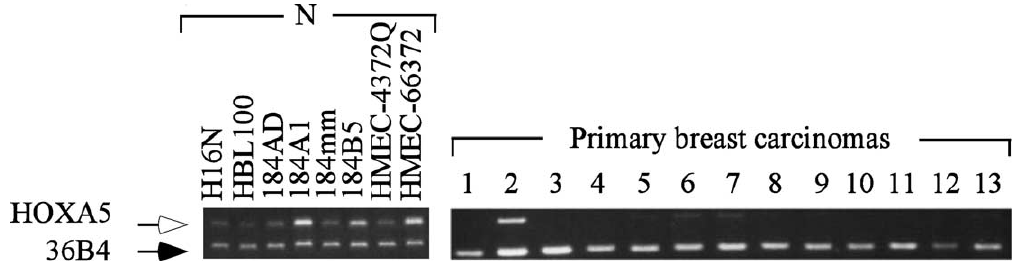
Fig. 2. HOXA5 expression in normal mammary epithelial cultures and primary breast carcinomas. RT-PCR analysis for the expression of HOXA5 was performed on a series of normal breast cultures and primary carcinomas (1–13). Amplification of the mRNA coding for the hu- man ribosomal protein 36B4 was used as an internal loading control. As observed, normal breast cells expressed HOXA5 (open arrow). How- ever, in primary breast carcinomas HOXA5 expression was decreased. HOXA5 (open arrow) and 36B4 (closed arrow) cDNAs were amplified using the following primer sets: HOXA5-5 (cid:1) -ACCCACATCAGCAGCAGAG-3 (cid:1) (sense) and 5 (cid:1) -TCGGAGAGGCAAAGAGCAT-3 (cid:1) (antisense); 36B4-5 (cid:1) -GAAGGCTGTGGTGCTGATGG-3 (cid:1) (sense) and 5 (cid:1) -CCCCTGGAGATTTTAGTTGGT-3 (cid:1)